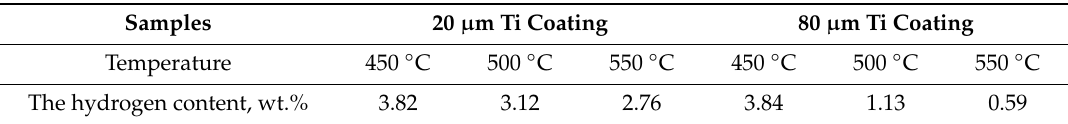
Table 5. Hydrogen content depending on the hydrogenation temperature for each